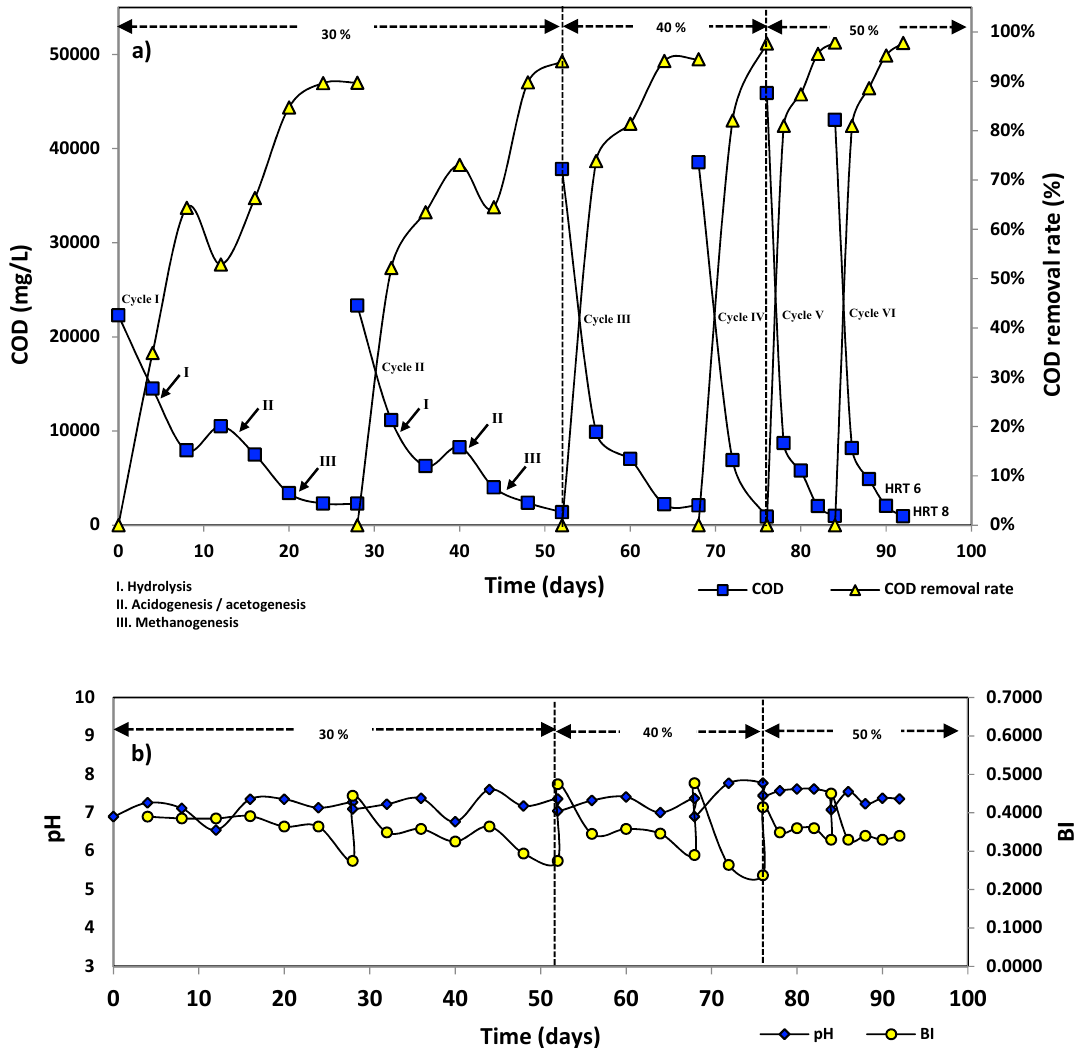
Figure 5. Kinetic AGS acclimatization in batch reactor. ( a ) Monitoring of COD degradation and ( b ) Monitoring of pH and alkalinity factor.